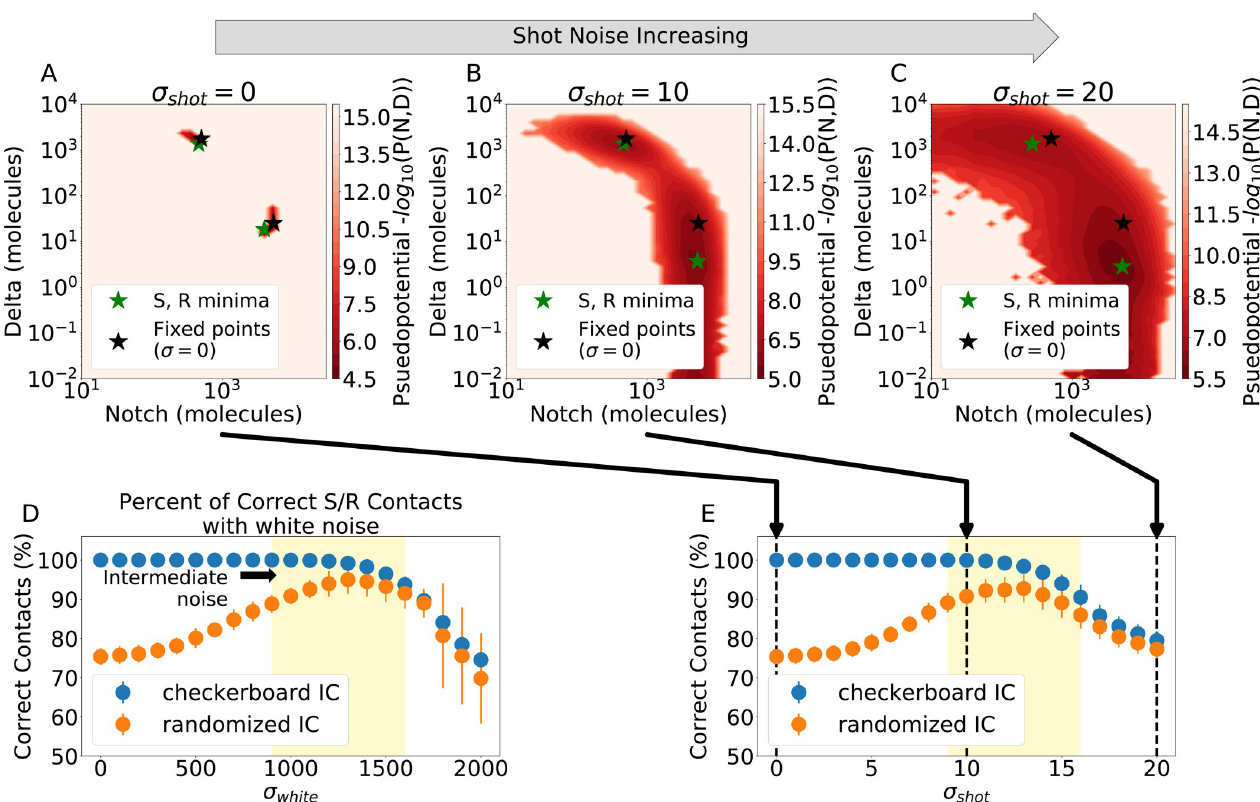
Fig 4. Stochastic influence on lateral inhibition and multicell pattern formation. (a) Pseudopotential landscape for the multicell model in the absence of noise ( σ shot = 0) for a single independent simulation. X- and y-coordinates represent cellular levels of Notch and Delta, respectively. Green starred dots depict the location of the landscape minima corresponding to S and R states, while black starred dots depict the location of the S and R states in a perfect checkerboard pattern. (b) Same as (a) but for σ shot = 10. (c) Same as (a) but for σ shot = 20. Panels (a)-(c) show that shot noise maintains separation of the Sender and Receiver states even as the system explores the state space. (d) The percentage of correct contacts (i.e., Sender-Receiver) as a function of white noise for random initial conditions (orange). (e) Same as (d) but for correct contacts as a function of shot noise. The lattice is influenced towards a more ordered system for intermediate levels of noise. For panels (d) and(e), results are averaged over 20 independent simulations of 9000 hr using random initial conditions after a 1000 hr relaxation period. For initially checkerboard systems, 20 independent simulations of 4000 hr are averaged after allowing for 1000 hr of relaxation.